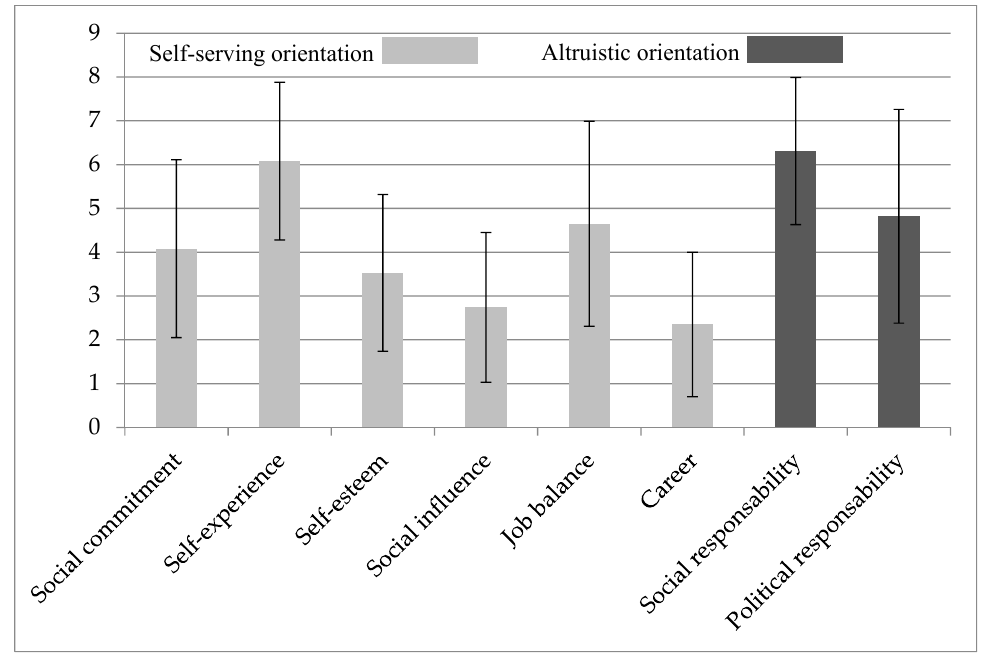
Figure 2. Special engagement motivators for refugee work of VAD. Scale from 1 = absolutely irrelevant to 9 = absolutely relevant.